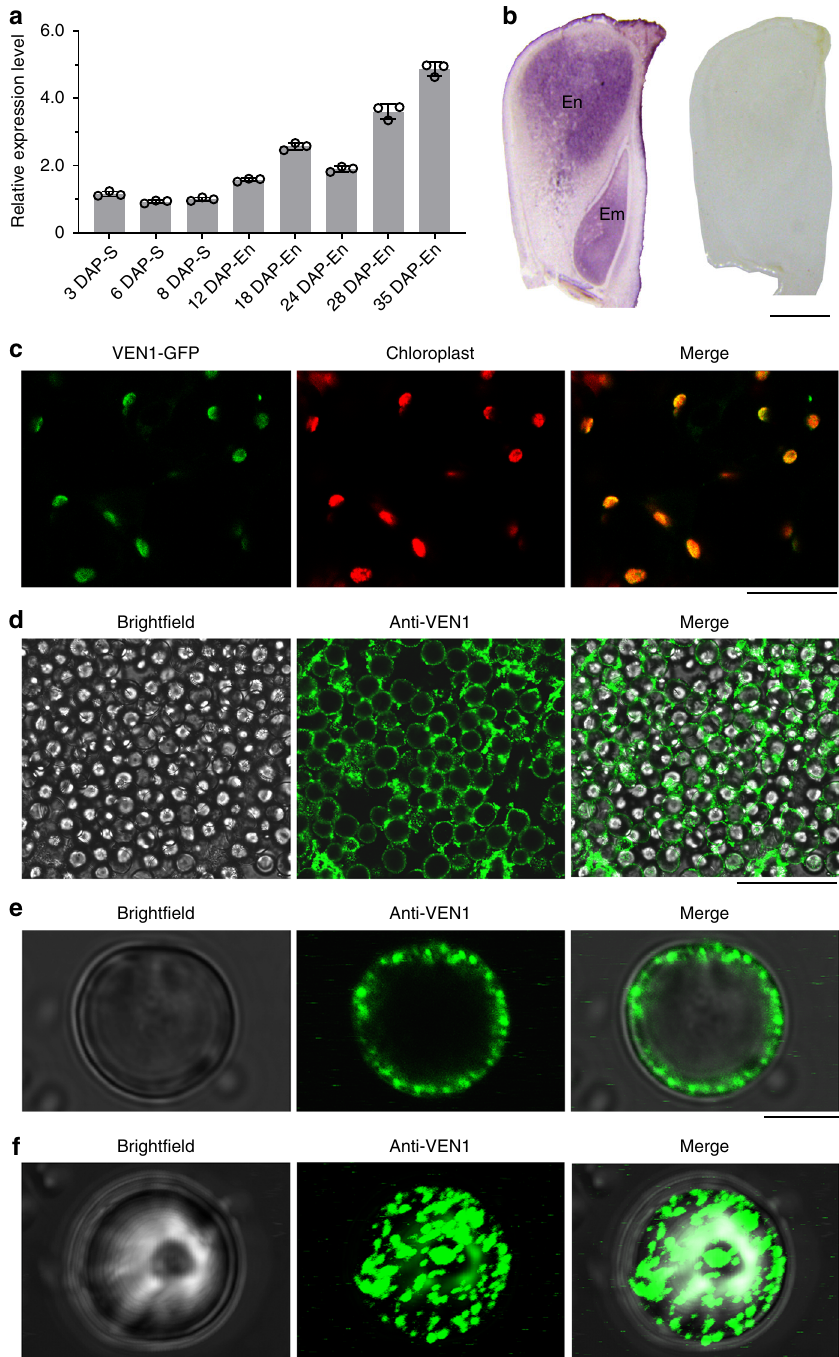
Fig. 2 The transcript and protein expression pattern of Ven1 during seed development. a RT-qPCR analysis of Ven1 expression during seed development. S, Seeds; En, Endosperm. Data are presented as mean values ± SD, n = 3 biologically independent samples. b RNA in situ hybridization of Ven1 in the 18- DAP seed. Left panel, hybridization with antisense probes; right panel, hybridization with sense probes. Scale bar, 1 mm c Subcellular localization of VEN1- GFP in Nicotiana benthamiana chloroplasts. Scale bar, 20 μ m. d Localization of VEN1 in endosperm starchy cells by immuno fl uorescence. Scale bar, 50 μ m. e Ringlike localization of VEN1 on a planar SG. Scale bar, 5 μ m. f Localization of the VEN1 protein on the surface of a three-dimensional SG by Z-stack imaging. Scale bar, 5 μ m. The source data underlying a are provided as a Source Data fi